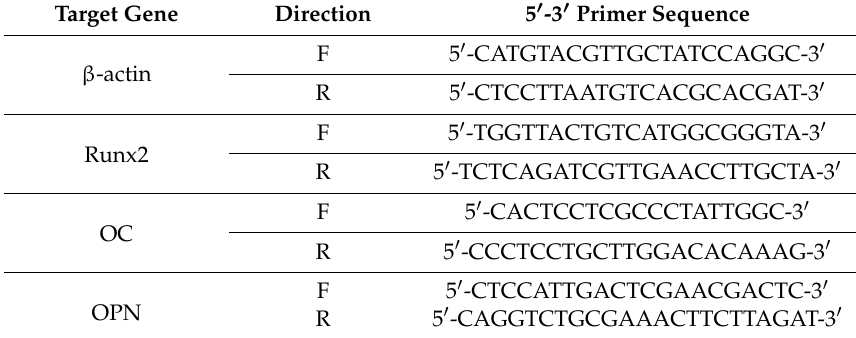
Table 1. The sequences of forward (F) and reverse (R) primers for real-time polymerase chain reaction